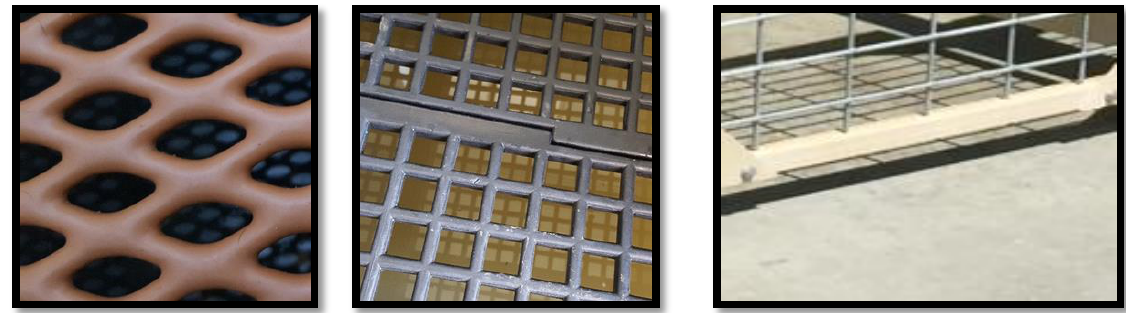
Figure 1. Flooring types. Indoor flooring assessed from far left: diamond-shaped coated expanded metal (DCEM), polypropylene (POLY), and concrete (CON). Table 2. Facility information. Types of indoor and outdoor flooring, size of dog housing, and amount of exercise at each facility. Note that facilities 4 and 5 each had indoor kennels with either DCEM or CON.